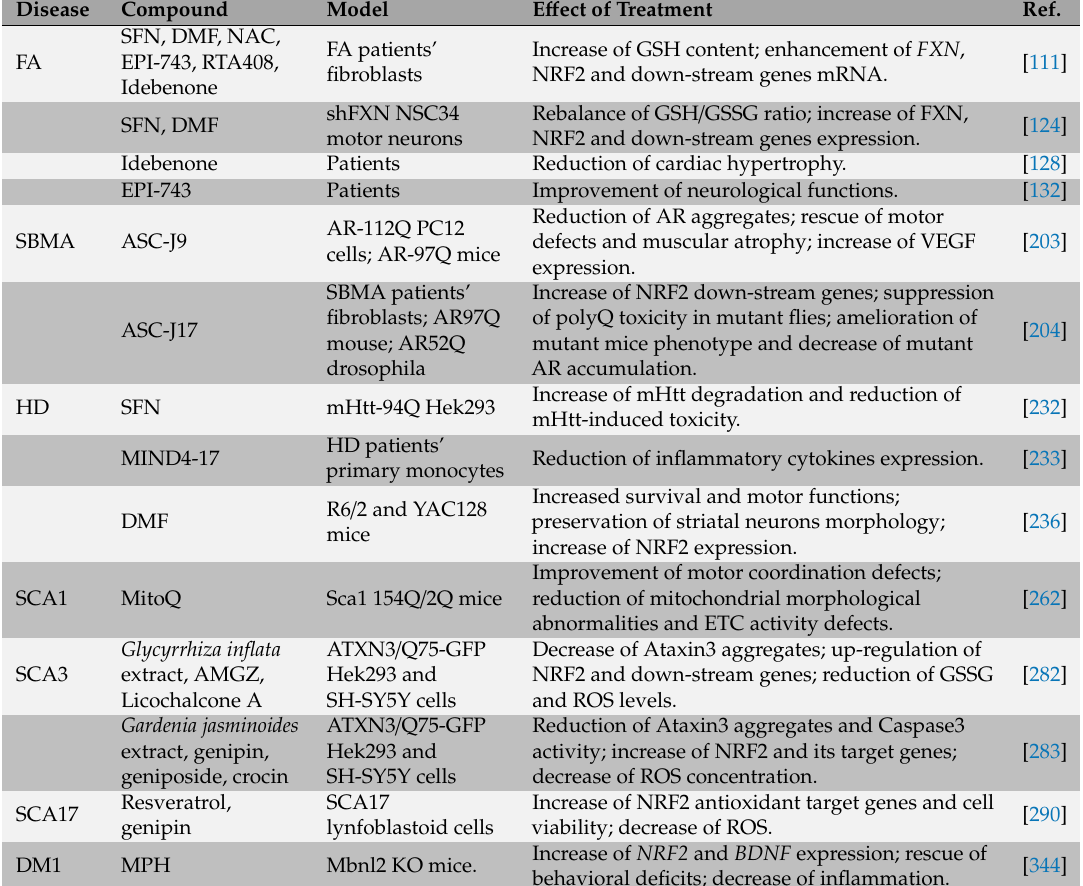
Table 1. Table summarizing findings on antioxidant drugs / NRF2-activating compounds and their main e ff ects in DNA repeat expansion